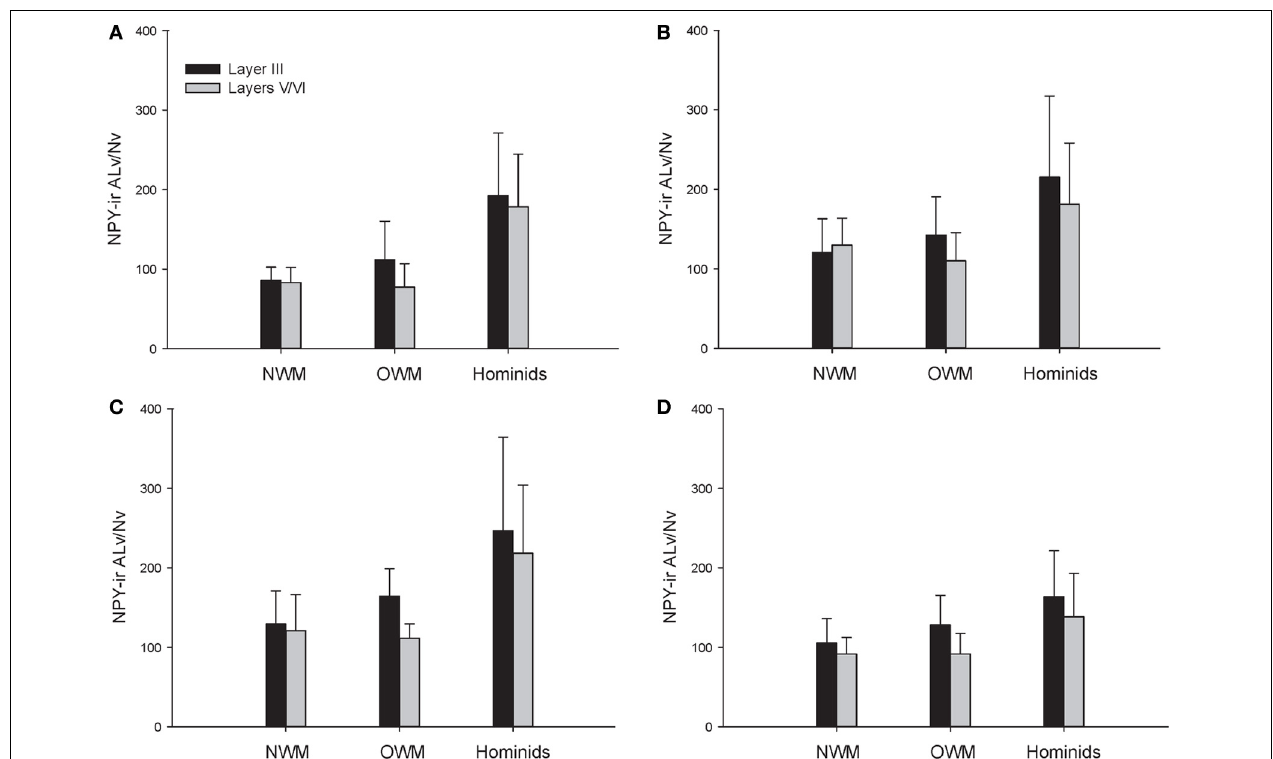
FIGURE 8 | NPY-irALv/Nv collapsed into phylogenetic groups for (A) area 10, (B) area 24, (C) area 44, and (D) area 22. OWM, Old World monkeys; NWM, New World monkeys. Means are shown by bars. Error bars indicate standard